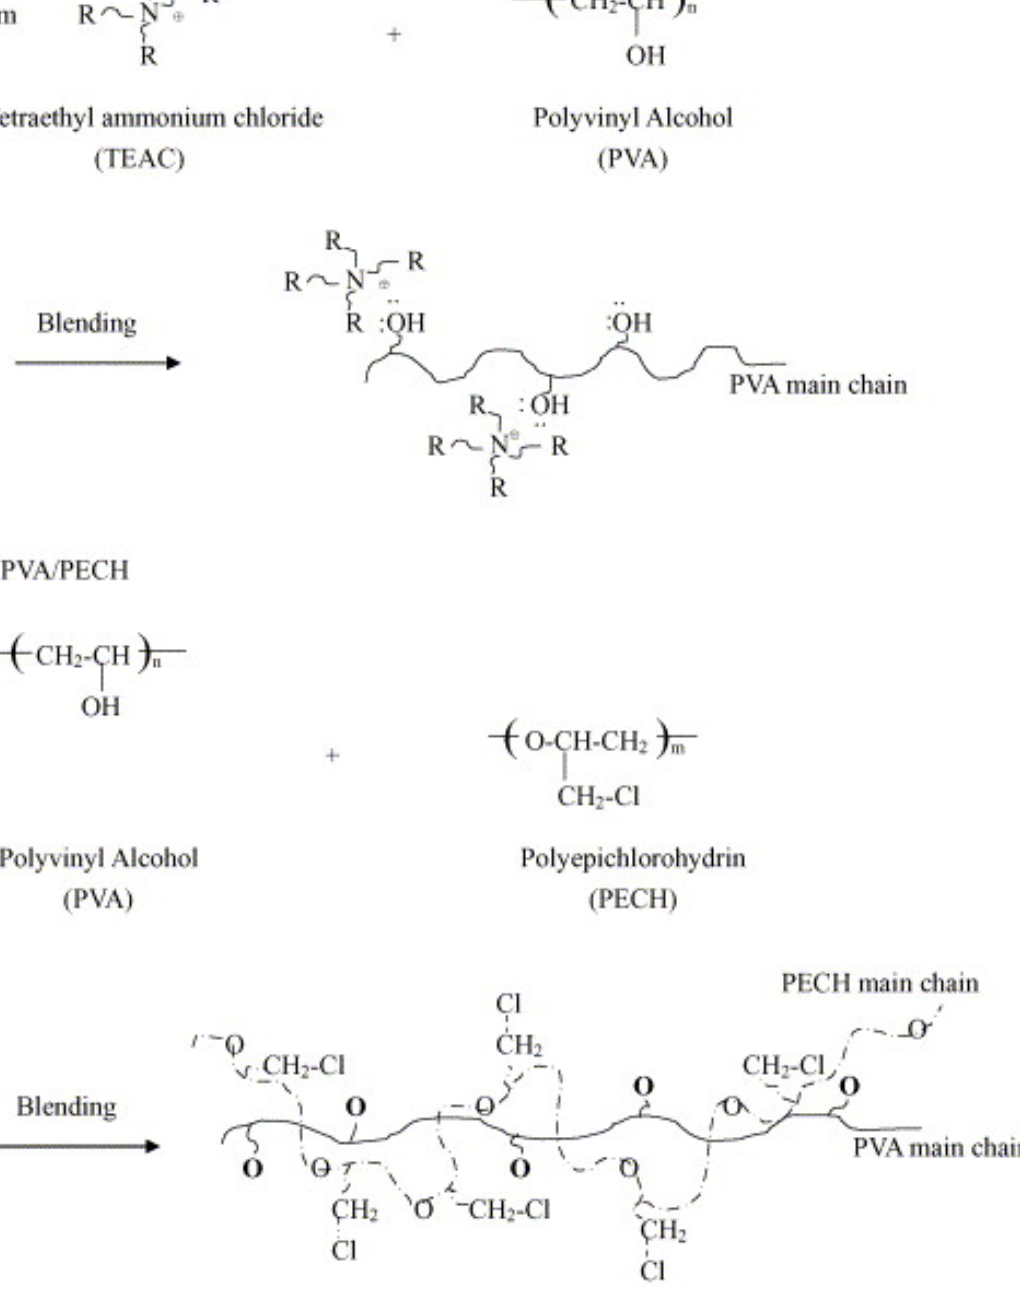
Figure 8. Preparation of the PVA polymer blended with ( a ) TEAC and ( b ) PECH (Reprinted with permission from ref. [119] Copyright 2005 Elsevier).